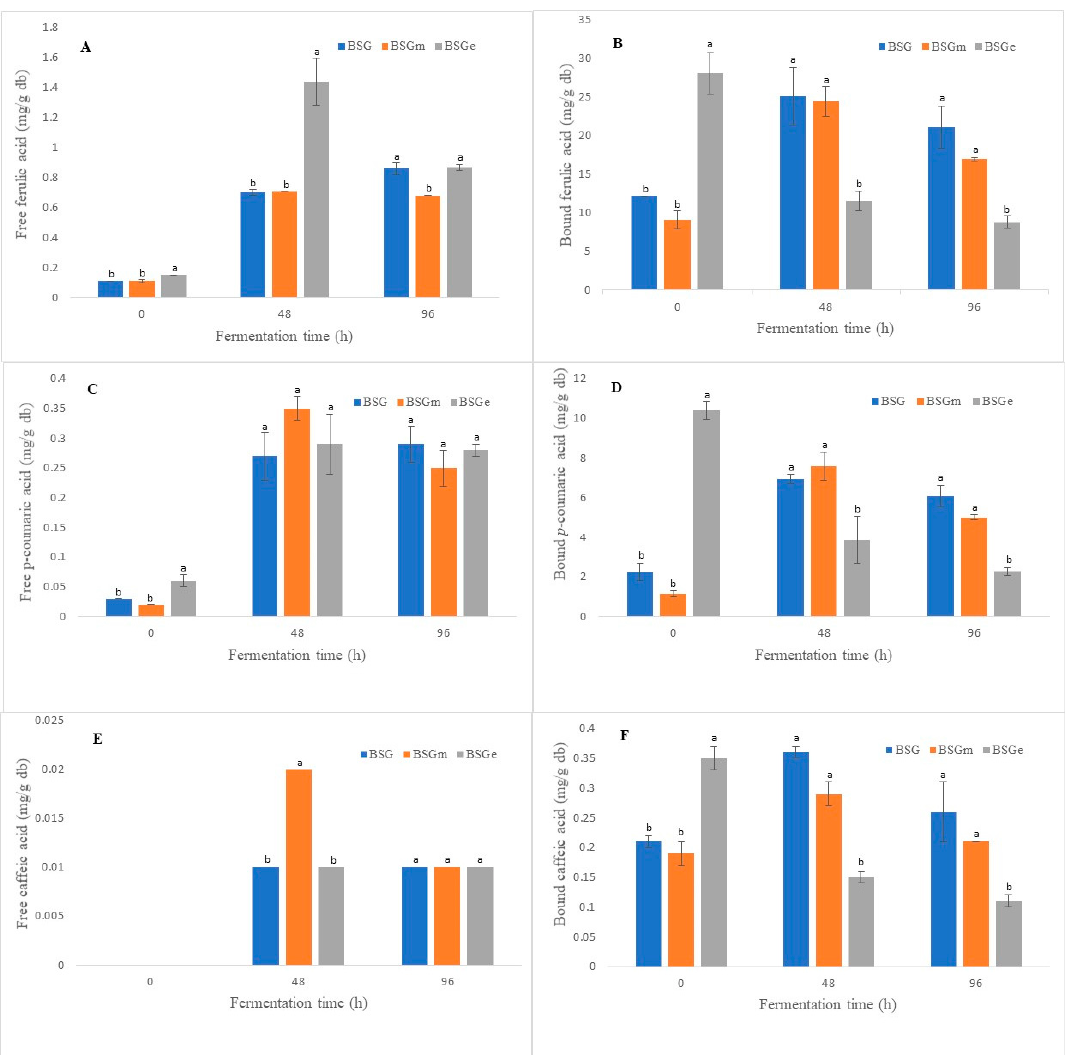
Figure 3. Free and bound phenolic acids from unfermented samples (brewers’ spent grain, BSG; BSG milled, BSGm; BSG extruded, BSGe) and the fermented counterparts by Fusarium oxysporum after 48 h and 96 h. Subfigures correspond to free ferulic acid ( A ), bound ferulic acid ( B ), free p -coumaric acid ( C ), bound p -coumaric acid ( D ), free caffeic acid ( E ), and bound caffeic acid ( F ). Significant differences for each fermentation time are shown by the letters a, and b.